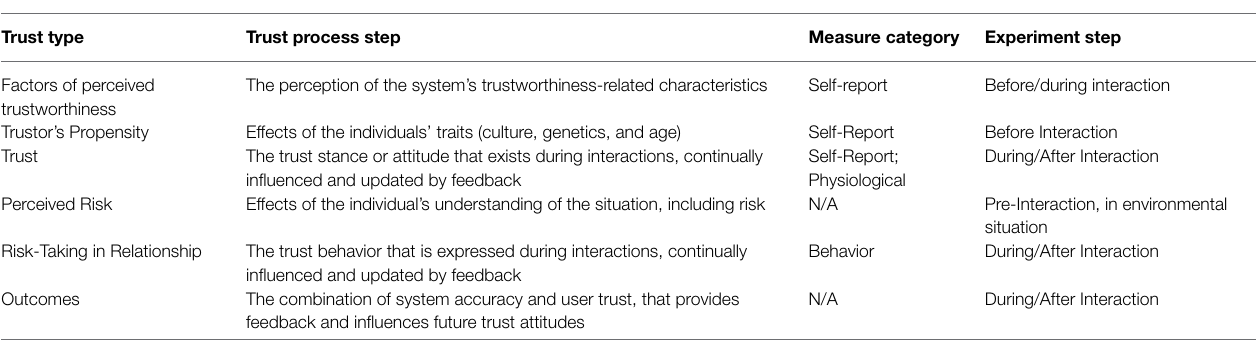
TABLE 1 | Comparing trust models to process and